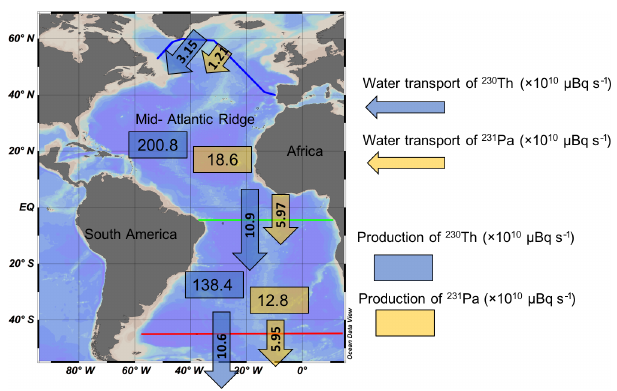
Figure 11. Fluxes of 230 Th (blue arrow) and 231 Pa (yellow arrow) across the GEOVIDE section (blue solid line), 4.5 ◦ S (green solid line), and 45 ◦ S (red solid line). Also shown is production of 230 Th (blue box) and 231 Pa (yellow box) in the North Atlantic (between GEOVIDE section and 4.5 ◦ S) and in the South Atlantic (between 4.5 and 45 ◦ S), based on calculation in Deng et al. (2014). These fluxes indicate that 4% of the 230 Th and 26% of the 231 Pa produced in the North Atlantic is exported southward by ocean